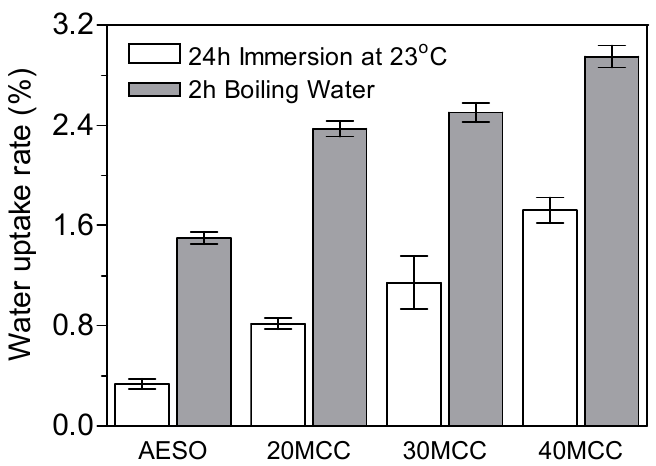
Figure 5. Effect of MCC loading on the water absorption of MCC/AESO composites.